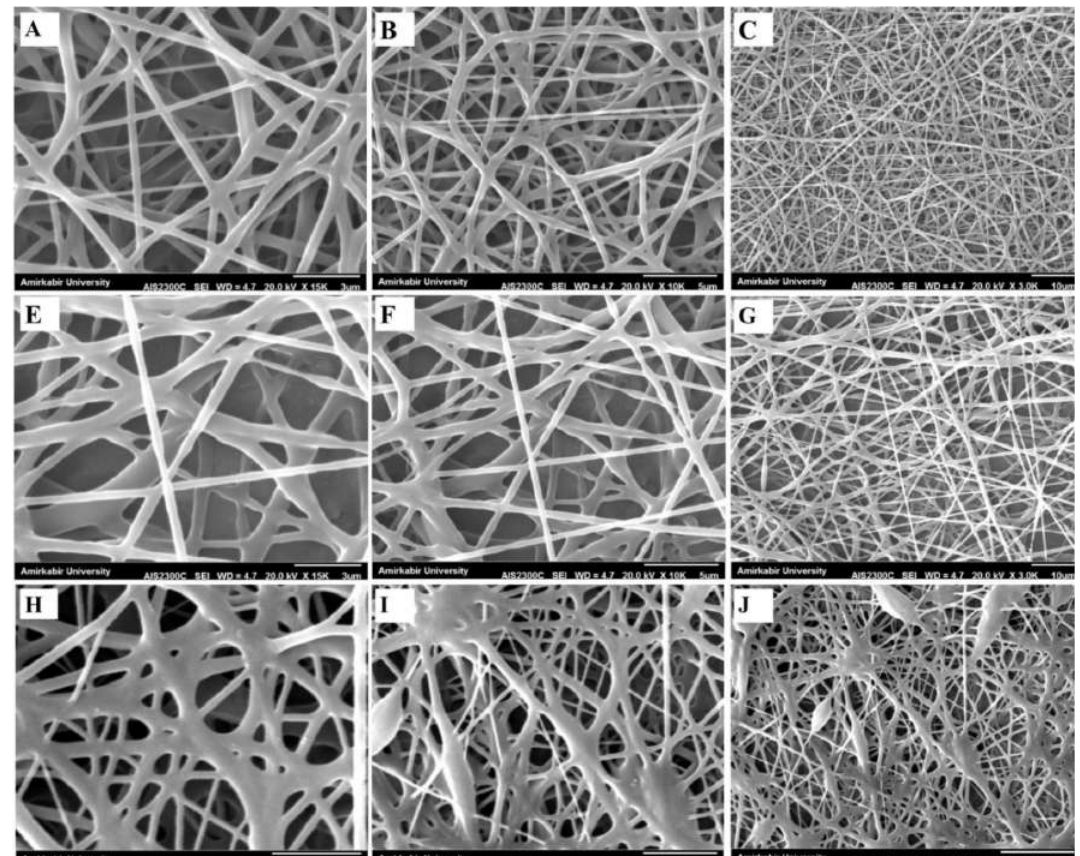
Fig. 1. Electrospun nanofibers of polyurethane which are synthesized by different solvents. (A-C) when polyurethane has dissolved in HFIP. (E-F) when polyurethane dissolved in DMF. (I–H) when polyurethane dissolved in new solvent chloroform/methanol